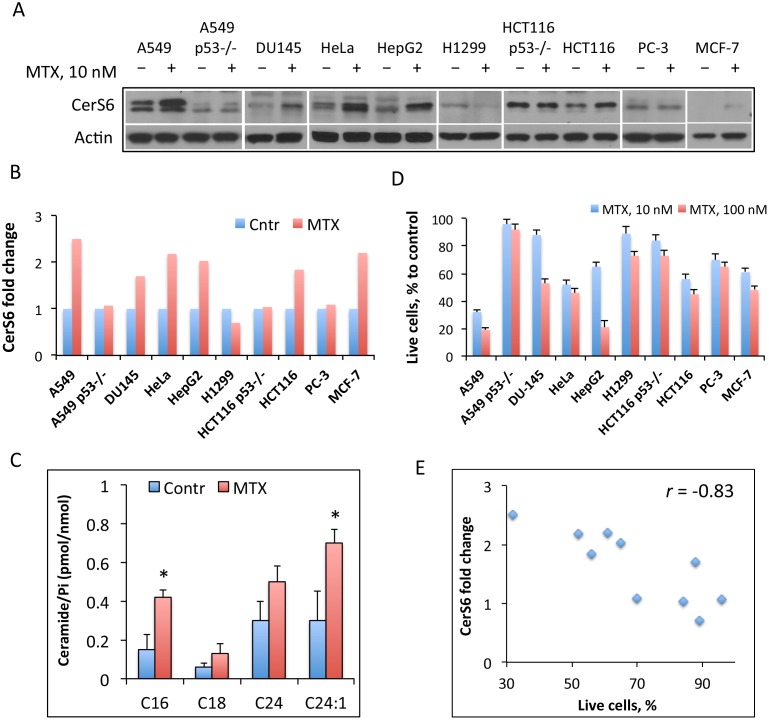
Effects of MTX on CerS6, ceramide levels and cellular proliferation.(A) Levels of CerS6 (Western blot) in cancer cells with and without MTX treatment. Cells were collected 48 h after MTX was added. (B) Changes in CerS6 levels after treatment with 10 nM MTX for 48 h (calculated from A). The intensity of bands was quantified using ImageJ software. In all cases, normalization for levels of actin was performed. (C) Changes in levels of selected ceramides in A549 cells after treatment with 10 nM MTX; Pi, total phospholipid inorganic phosphate present in cell extracts. Student’s t-test was performed for statistical analysis of the changes in ceramide levels and asterisks indicate statistically significant differences (p<0.05). (D) Antiproliferative effect of MTX (10 and 100 nM) in a panel of cancer cell lines. Live cells were assessed by MTT assay. Error bars show SD of four measurements. Differences between control and drug treated groups were statistically significant (calculated by one-way ANOVA) with p value below 0.0007 in all cases with the exception of A549 p53-/- cells (p = 0.0357). (E) Scatter plot of CerS6 protein levels (from panel B) versus cell survival after MTX treatment (from panel D) for ten cell lines indicated in the above panels. Pearson’s coefficient (r = −0.83; n = 10; p<0.01) indicates strong negative correlation between changes in CerS6 levels and cell survival upon MTX treatment.